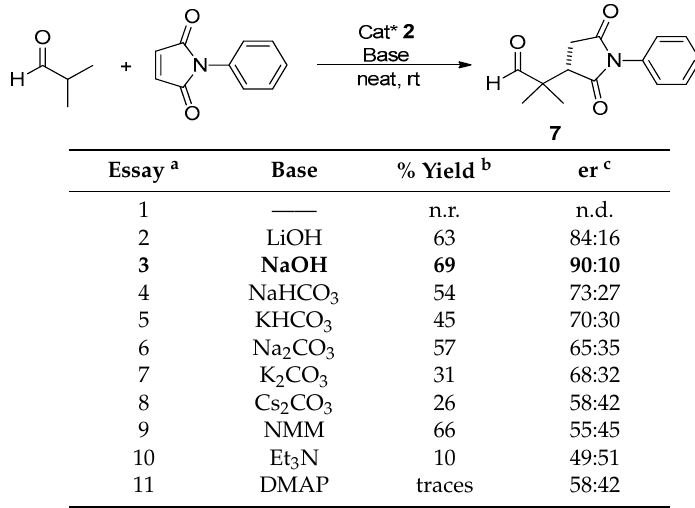
Table 3. Michael addition reaction of isobutyraldehyde to N -phenylmaleimide organocatayzed by phenylalanine- β -alanine (Phe- β -Ala, 2 ) in the presence of different bases.